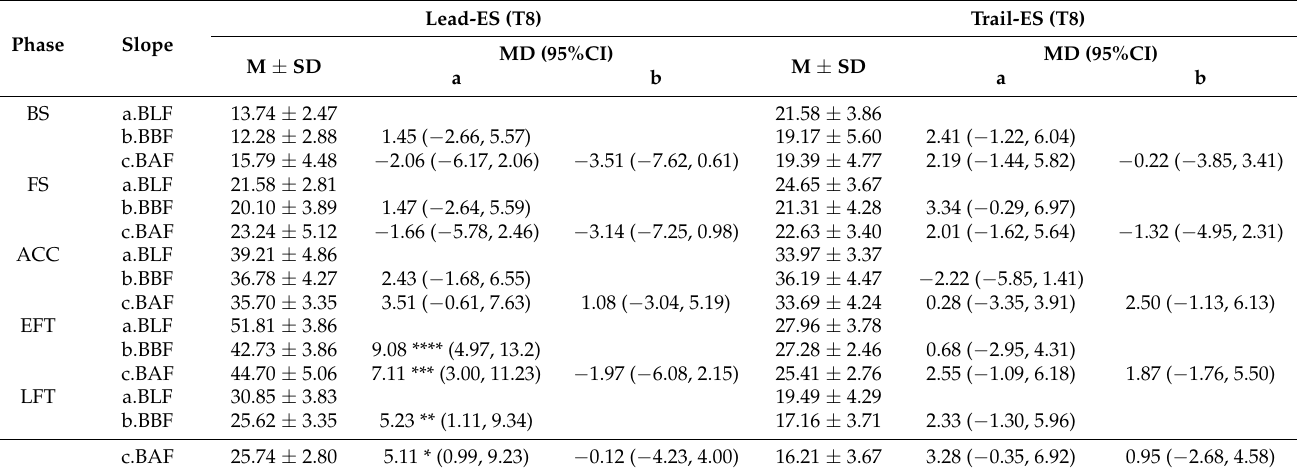
Table 2. EMG (MVC) by Lead-ES(T8) and Trail-ES(T8) muscle results for the BLF, BBF, and BAF at different events.